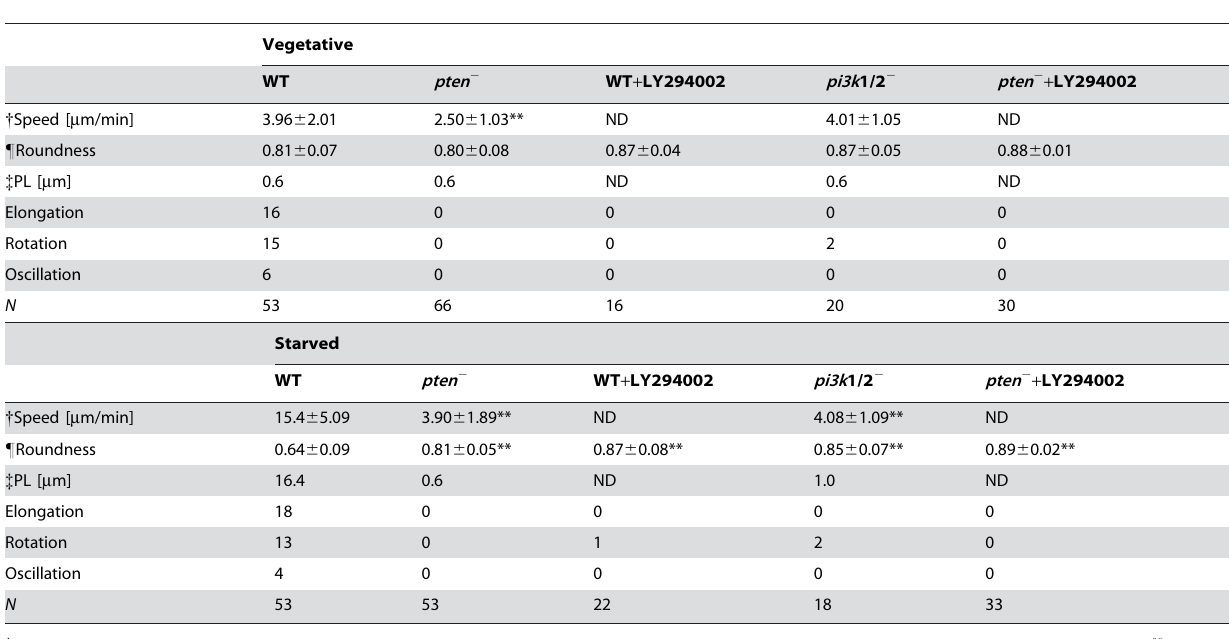
Table 1. Parameters of spontaneous cell